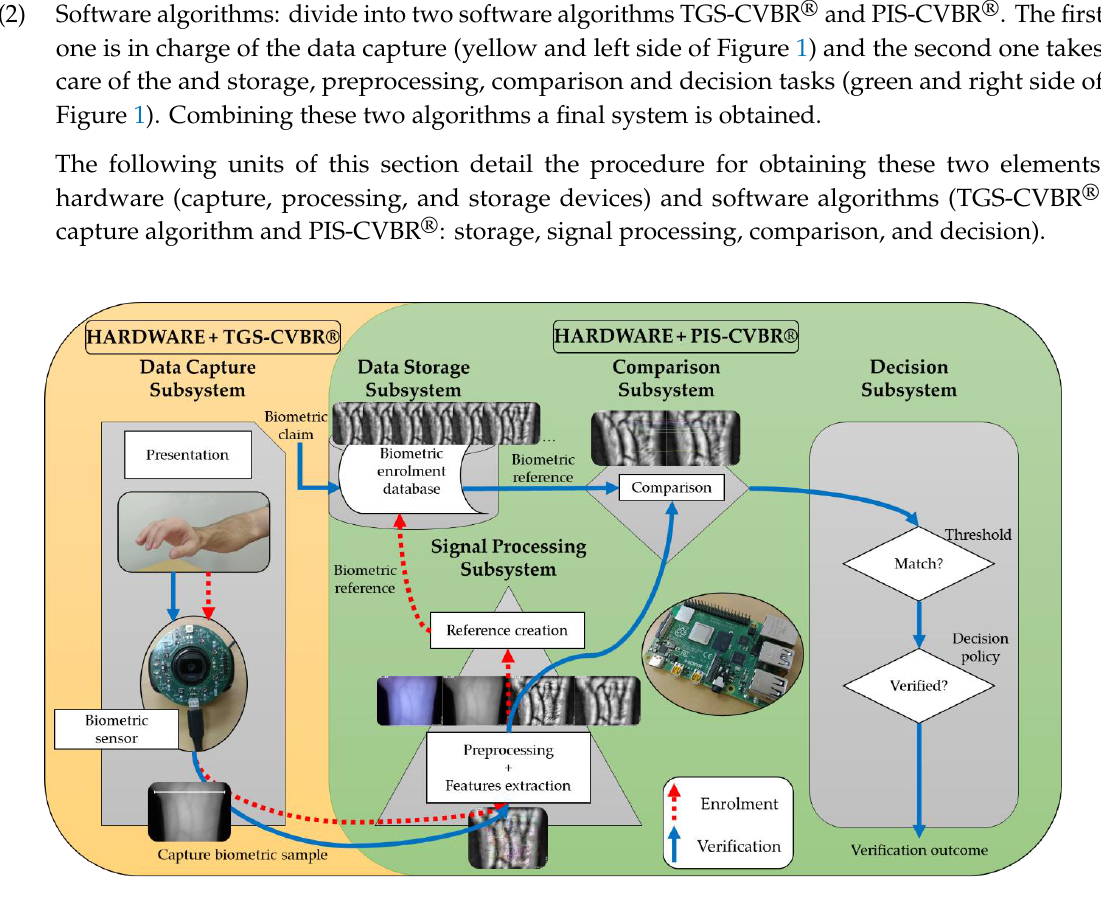
Figure 1. Components of the experimental wrist VBR system.